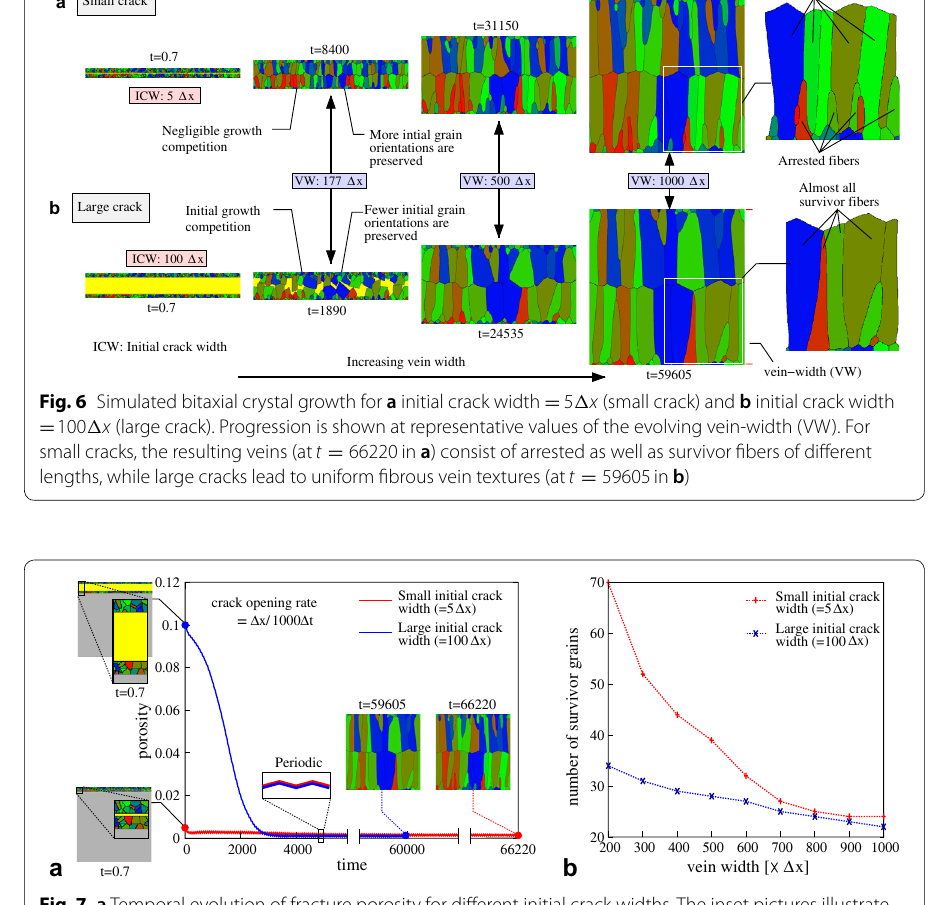
Fig. 7 a Temporal evolution of fracture porosity for different initial crack widths. The inset pictures illustrate the initial and final vein morphologies at the end of simulation. b Plot of the number of survivor grains with the evolving vein-width for different values of initial crack